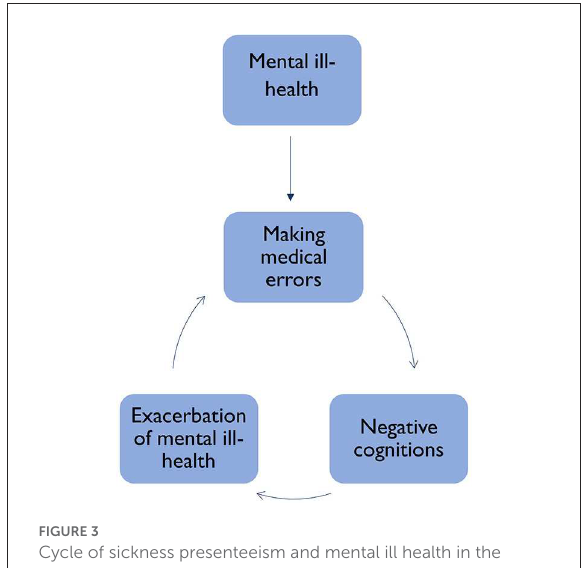
FIGURE3 Cycle of sickness presenteeism and mental ill health in the veterinary industry.